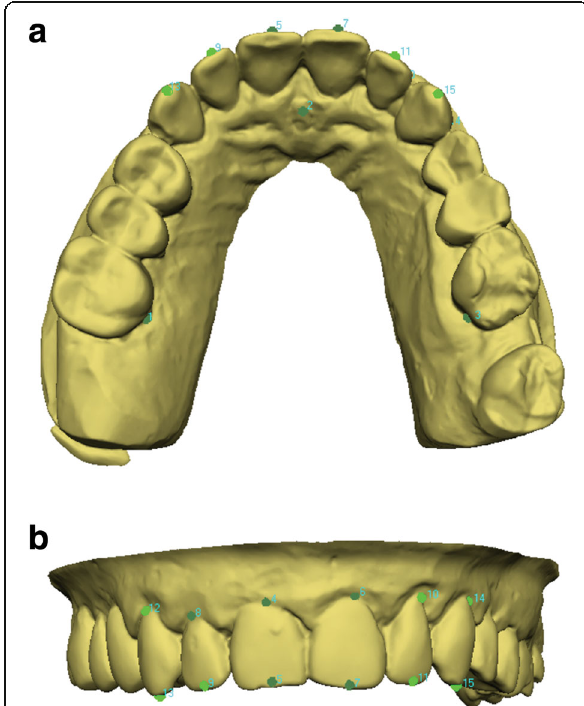
Fig. 1 Torque measurement using VAM software. Reference landmarks and points defining the labial FACC of the anterior teeth were localised on every digital model. a Occlusal view and b frontal